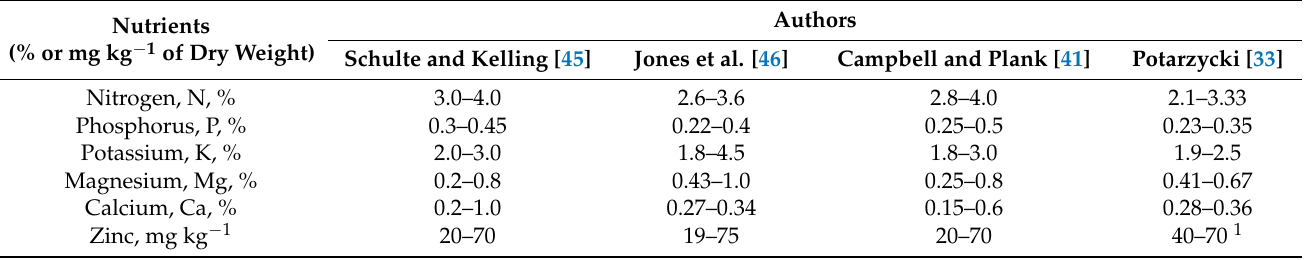
Table 2. Evaluation of maize nutritional status based on nutrient sufficiency ranges for the early leaf—the beginning of